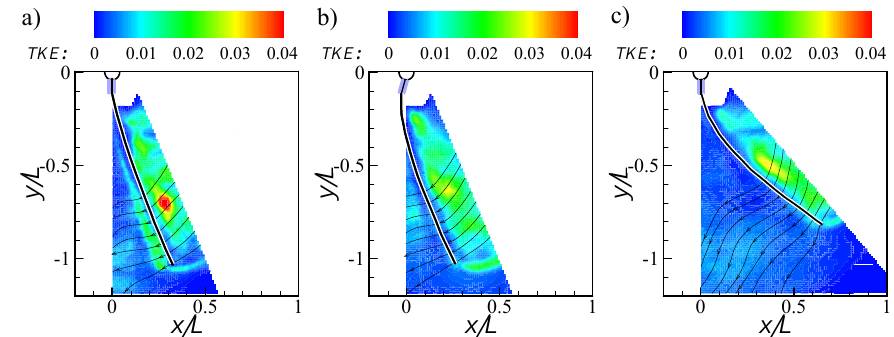
Figure 8. Phase-locked distributions of normalized turbulence kinetic energy TKE = TKE / ( ω R ) 2 in the vicinity of the thick plate at: ( a ) ω = 60 rpm; ( b ) ω = 90 rpm; and ( c ) 120